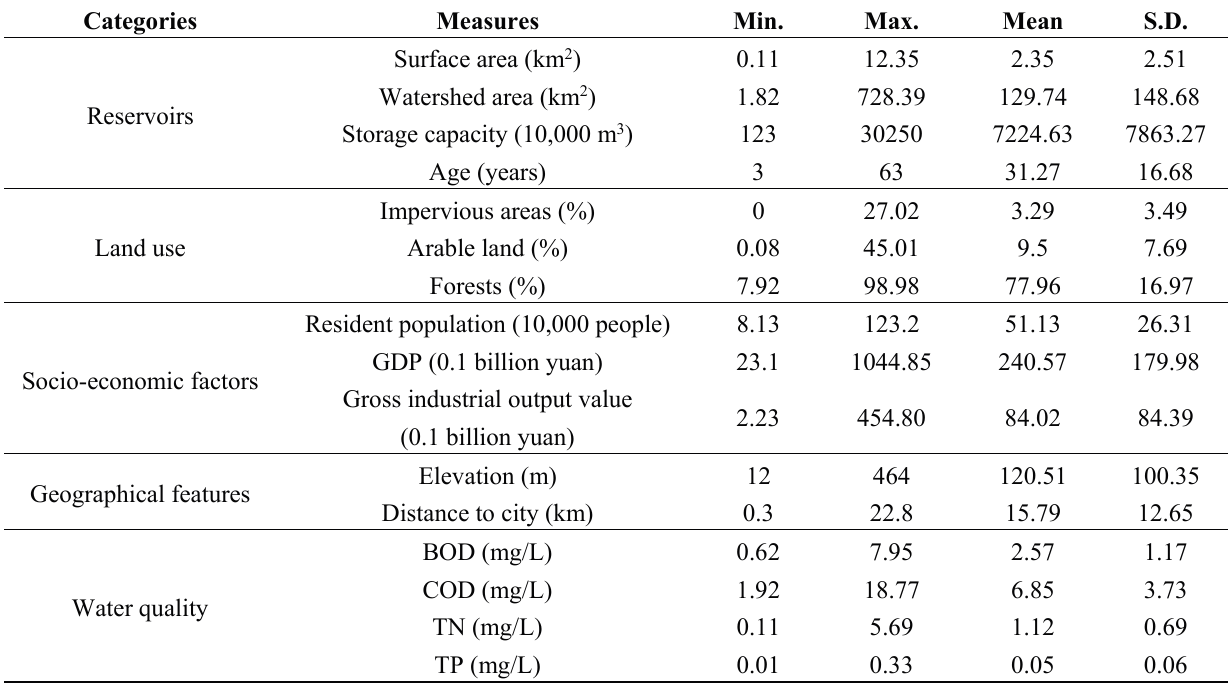
Table 1. Descriptive statistics of the studied parameters.